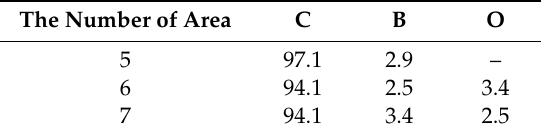
Table 4. Sample 2 elemental analysis.